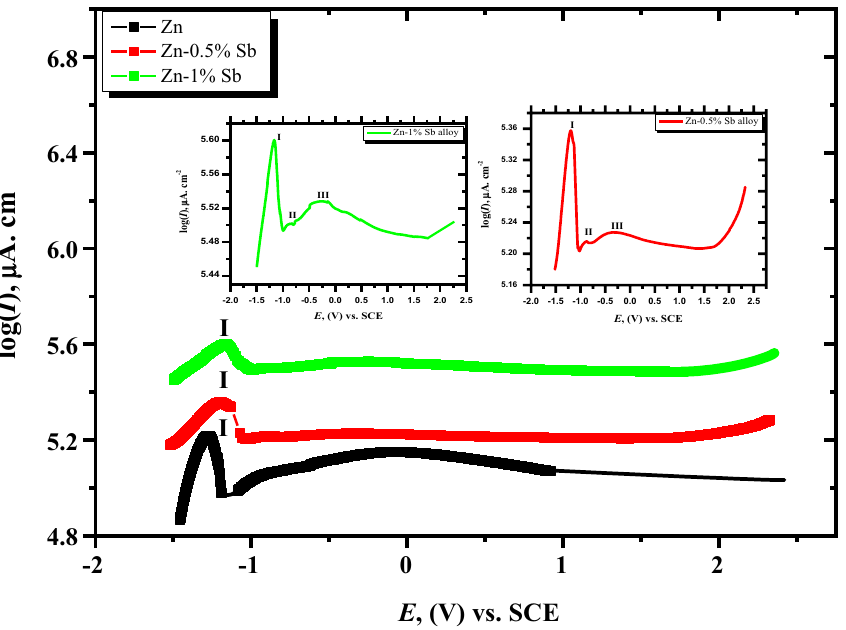
Figure 1. Potentiodynamic polarization behavior in 6 M KOH at 25 °C for pristine Zn metal and its